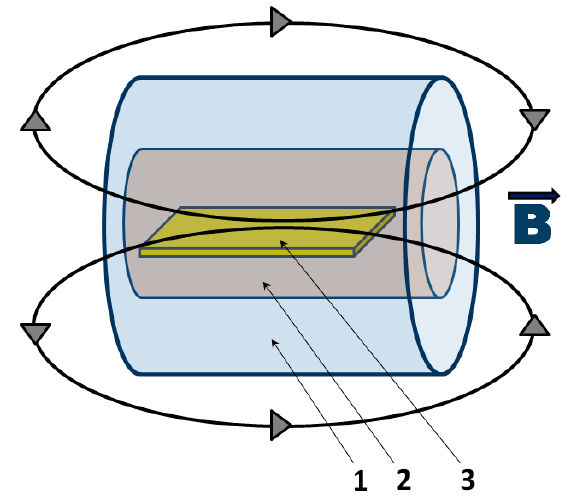
Figure 5. Schematic showing the placement of the samples with respect to the MRI instrument and to the magnetic field (B). The components are: 1 - magnet, 2 - MRI chamber, 3 – PET-SWCNT